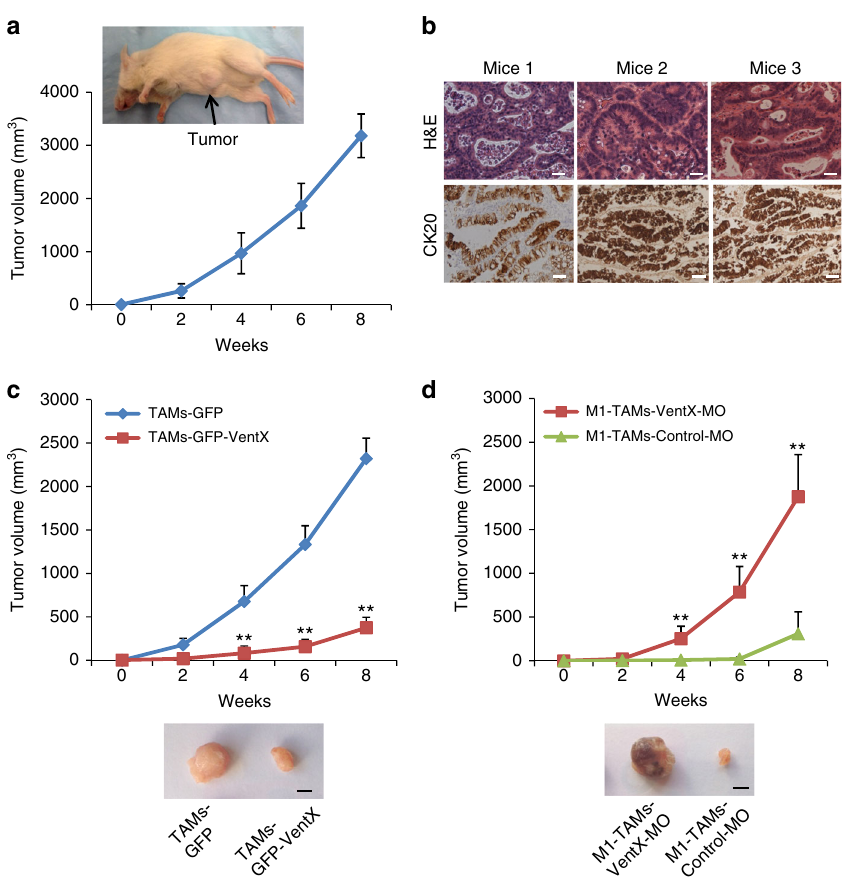
Fig. 6 VentX-regulated TAMs modulate tumorigenesis in vivo. a A NSG-PDX model of human colon cancers. Small pieces of colon cancer tissues were transplanted into subcutaneous space on the abdominal side of NSG mice and the growth of the tumors were observed for 8 weeks. Data shown were results of seven independent replicates of the experiments. b H&E and CK20 staining of tumors resected from three NSG-PDX mice. Scale